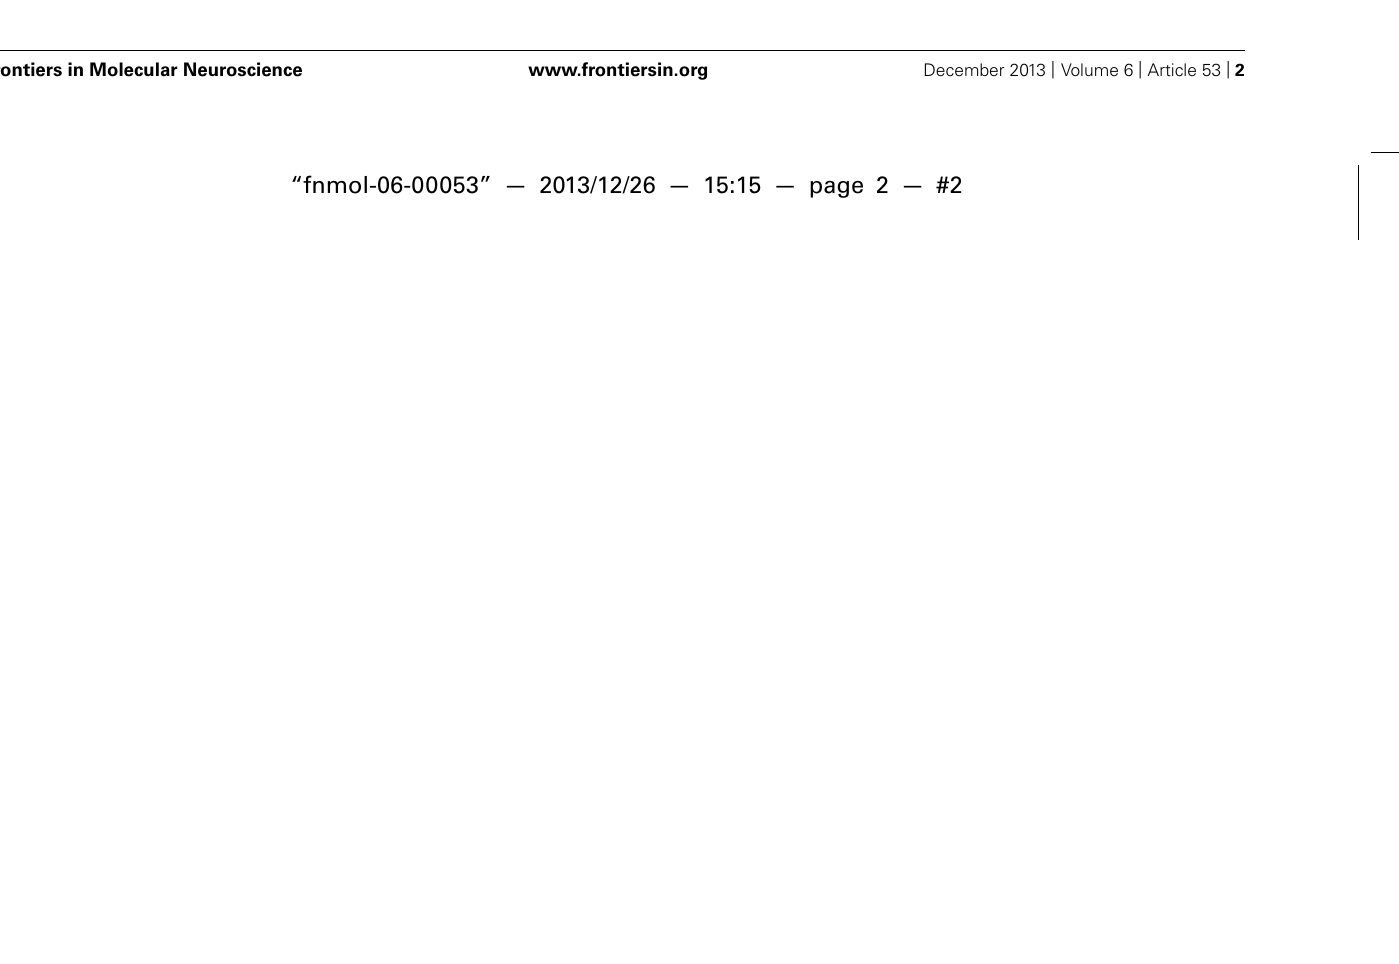
FIGURE 1 |An overview of known regulatory mechanisms for lncRNA. Transcription from an upstream promoter can negatively or positively affect the expression of a downstream gene via (1) transcriptional interference mediated by inhibition of RNA Polymerase 2 recruitment, or by (2) inducing chromatin remodeling and histone modification. Alternatively, an antisense transcript is able to hybridize to the overlapping sense transcript and